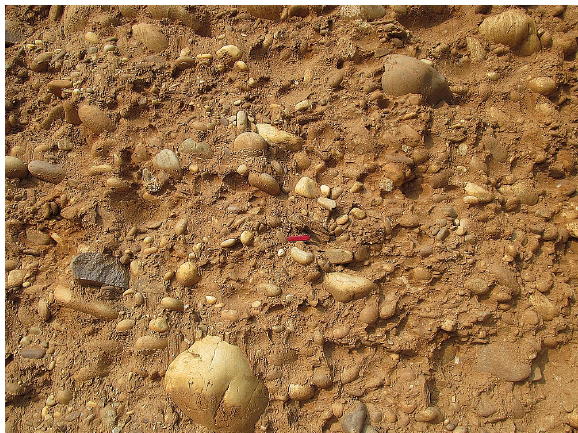
Figure A7. DVTT2 – terrace deposit ∼ 112m above modern chan- nel. Fluvially derived coarse cobble and sand (poorly sorted) con- glomerate interbedded within locally derived (Lesser Himalayan) phyllite deposits; 90mm long penknife for scale.